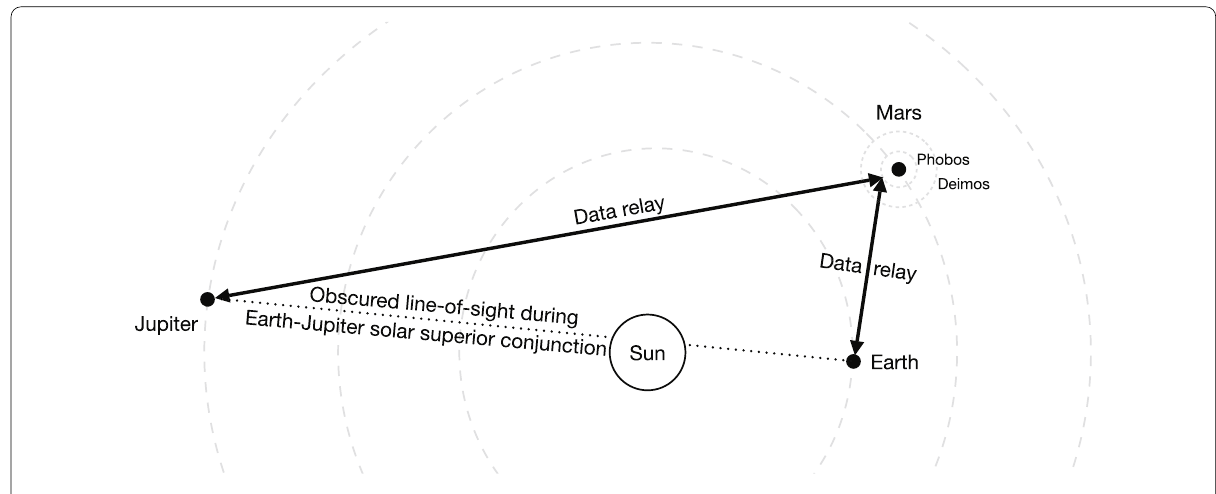
Fig. 8 Non‑scale illustration of Earth‑Jupiter solar superior conjunction, during which there is potential for data relay via the Mars system to reduce communications loss with spacecraft at Jupiter